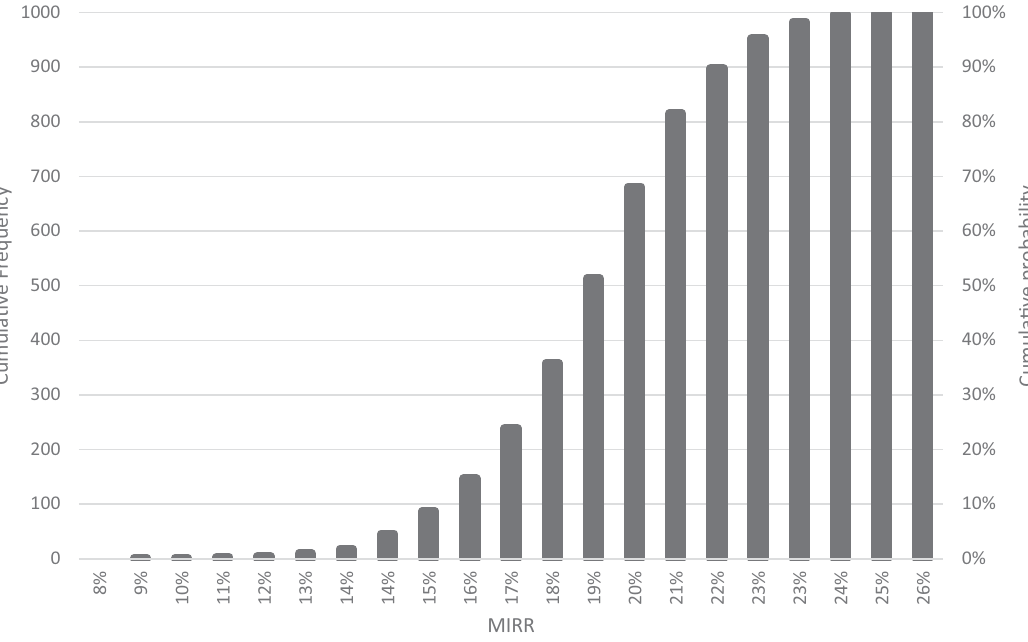
Fig. 6. Cumulative frequency of the simulated modi fi ed internal return rate for 1000 trials with market price, labor and feed cost with random and simultaneous